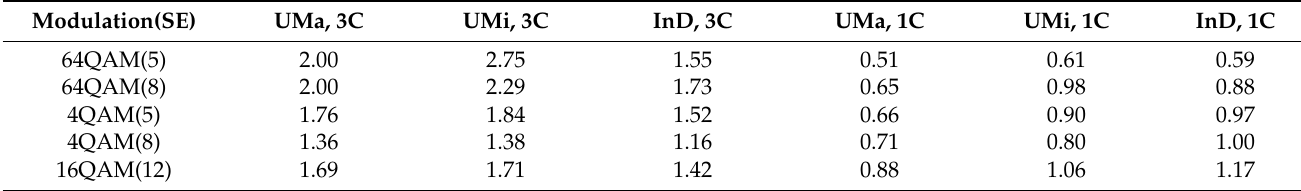
Table 2. SE in bps/Hz of different scenarios and cluster sizes 1 and